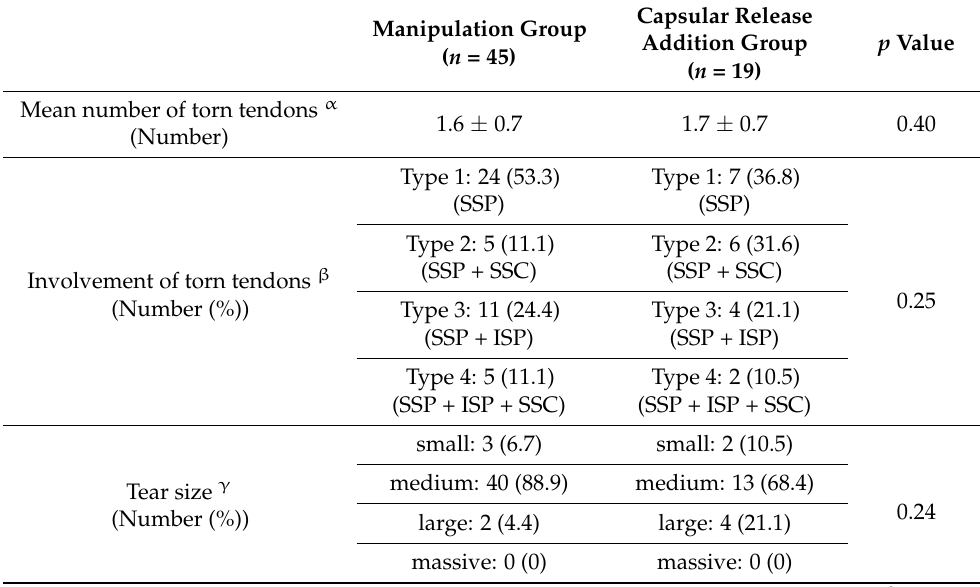
Capsular Release Manipulation Group p Value Addition Group ( n = 45) ( n = 19) 0.40 Type 1: 24 (53.3) Type 1: 7 (36.8) (SSP) (SSP)